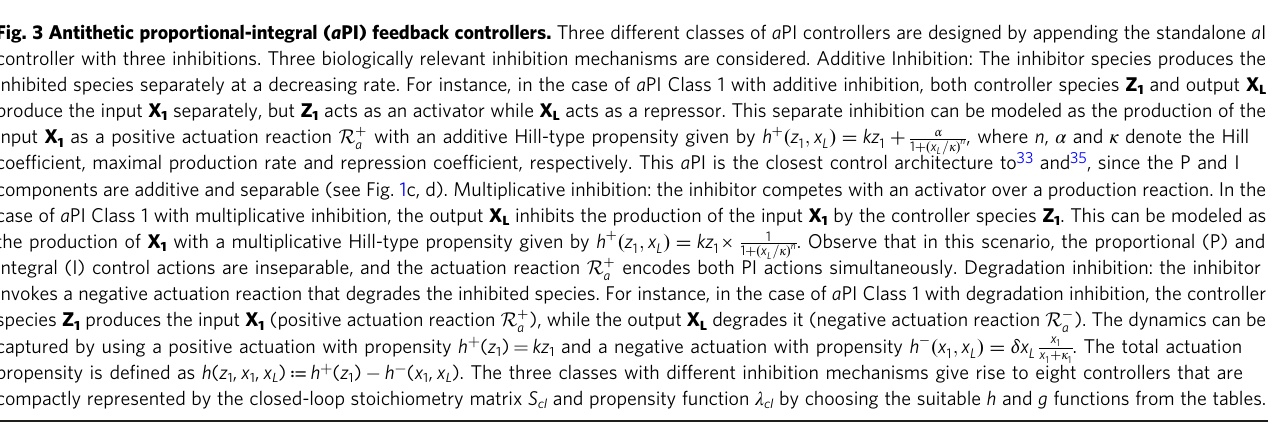
Fig. 3 Antithetic proportional-integral ( a PI) feedback controllers. Three different classes of a PI controllers are designed by appending the standalone a I controller with three inhibitions. Three biologically relevant inhibition mechanisms are considered. Additive Inhibition: The inhibitor species produces the inhibited species separately at a decreasing rate. For instance, in the case of a PI Class 1 with additive inhibition, both controller species Z 1 and output X L produce the input X 1 separately, but Z 1 acts as an activator while X L acts as a repressor. This separate inhibition can be modeled as the production of the input X 1 as a positive actuation reaction R þ with an additive Hill-type propensity given by h þ ð z 1 ; x L Þ ¼ kz 1 þ a components are additive and separable (see Fig. 1c, d). Multiplicative inhibition: the inhibitor competes with an activator over a production reaction. In the case of a PI Class 1 with multiplicative inhibition, the output X L inhibits the production of the input X 1 by the controller species Z 1 . This can be modeled as the production of X 1 with a multiplicative Hill-type propensity given by h þ ð z 1 ; x L Þ ¼ kz 1